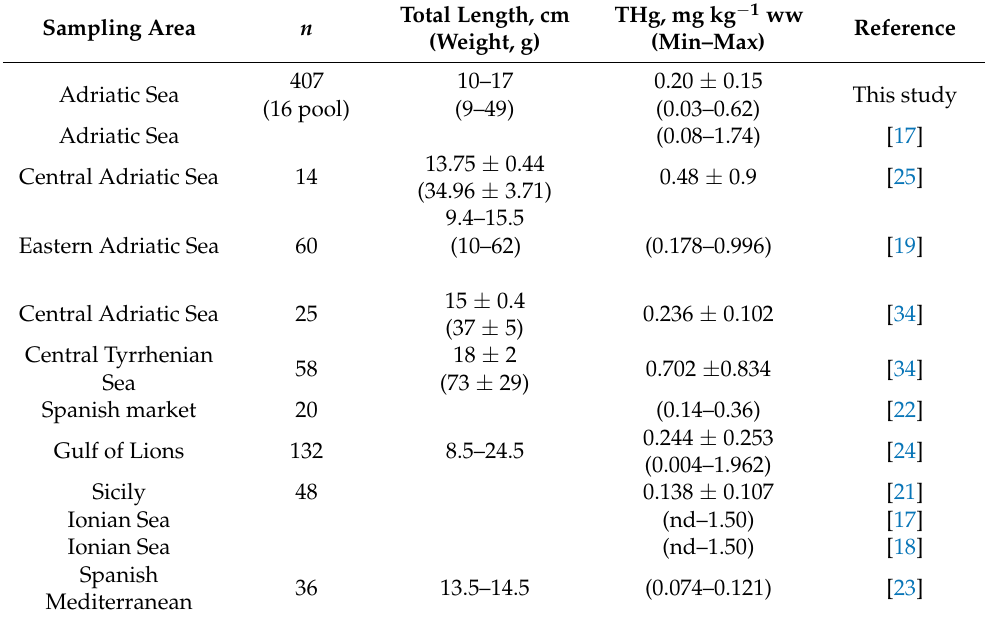
Table 3. THg concentrations (mg kg − 1 w.w.) recorded in other areas of the Mediterranean Sea. n , number of fish samples; mean ± standard deviation, range